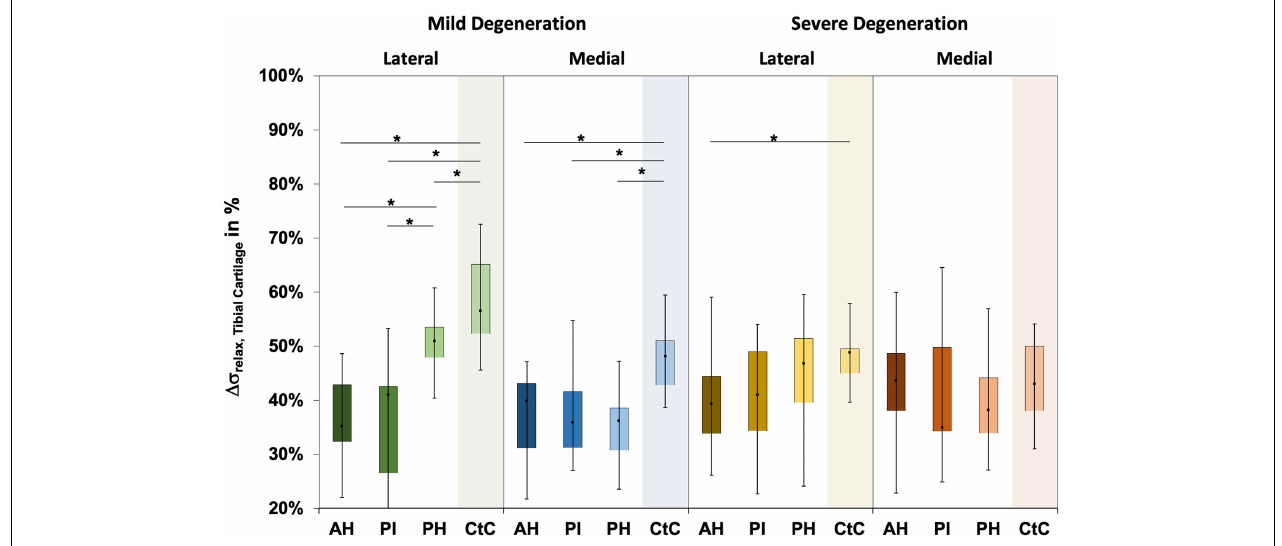
FIGURE 6 | Box plots (minimum, maximum, median, and 25th and 75th percentiles) of the relaxation percentages over the maximum stress ( (cid:49) σ relax ) of the mildly and severely degenerated tibial plateau articular cartilage (AC). Subdivided anatomical regions are: AH, anterior horn; PI, pars intermedia; PH, posterior horn; CtC, cartilage-to-cartilage contact area. Non-parametric statistical analyses: n = 12; * p < 0.05.